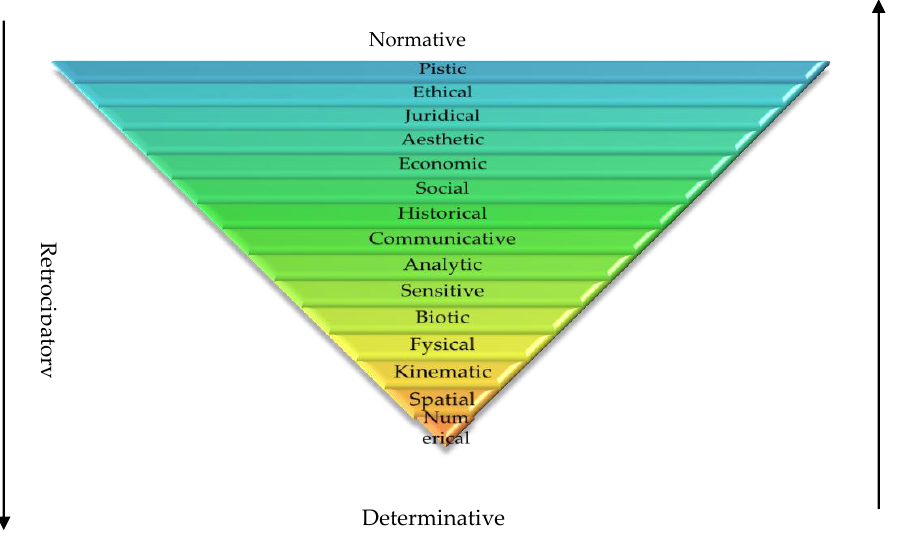
Figure 2. The modal spheres of Dooyeweerd [10]: When all the law spheres are respected, a good balance and sustainability are received.